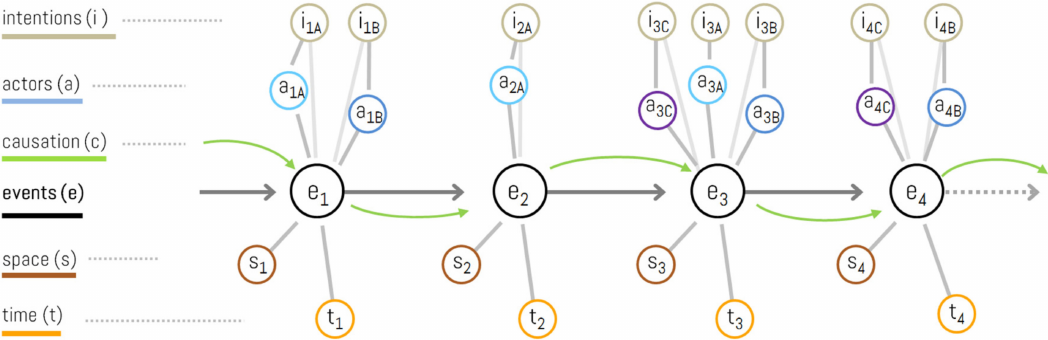
Figure 2. The comprehension of stories is said to result from the cognitive interconnection of narrated facts or events ( e ) according to five situative indices or data dimensions. Comprehension ensues if a recipient can situate events meaningfully in a developing situation or scenario that has been caused ( c ) by preceding events and interconnects specific actors ( a ) and their intentions ( i ) at a certain time ( t ), and in a certain place or space ( s